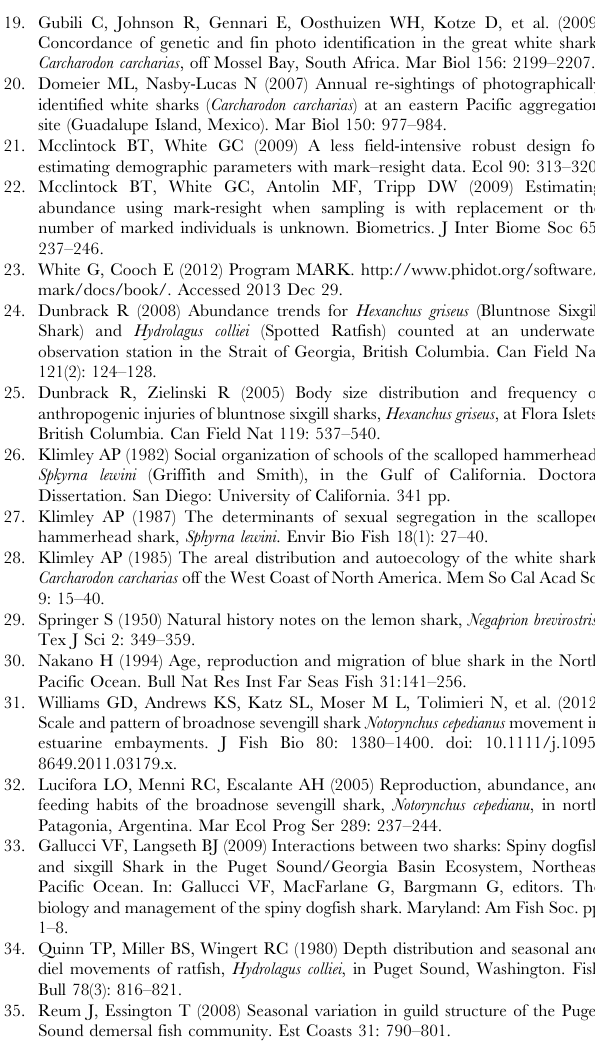
Table S1 List of individual sharks observed at Seattle Aquarium by research